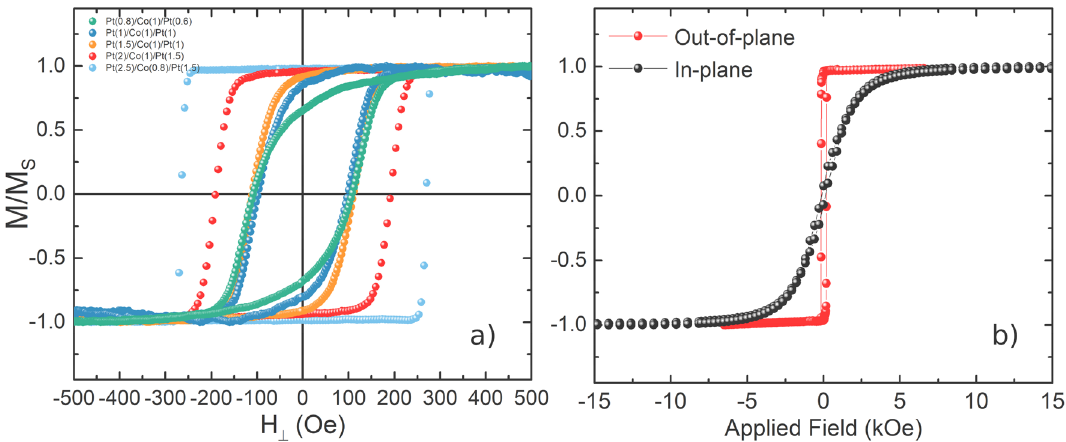
Figure 5. Room temperature magnetometry. All samples shown have a structure of Nb(15)/Pt/Co/Pt/Cu(0,5)/ MgO(3). Fields are swept at 200 Oe/s. ( a ) Polar MOKE hysteresis loops (red and light blue markers indicate those without Cu i.e. 0 nm), where the Pt/Co/Pt trilayers are described in the legend. All thickness values are in nm. ( b ) Representative in-plane and out-of-plane hysteresis loops taken via SQUID vibrating